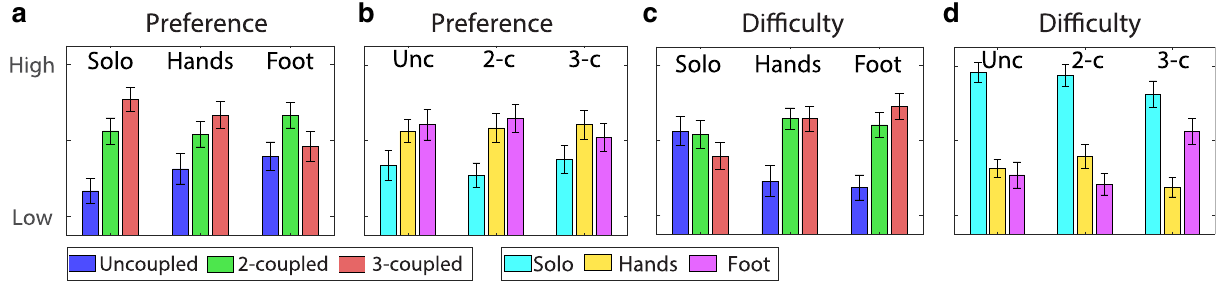
Figure 4. Questionnaire results: ( a , c ) preference and difficulty rank among the tasks for the solo and paired (hands-foot) sessions; ( b , d ) Preference and difficulty rank among the sessions for the three